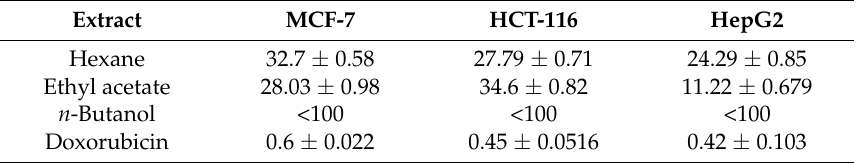
Table 1. IC 50 ( µ g/mL) of different extracts of A. lagopoides in different solid tumor cell